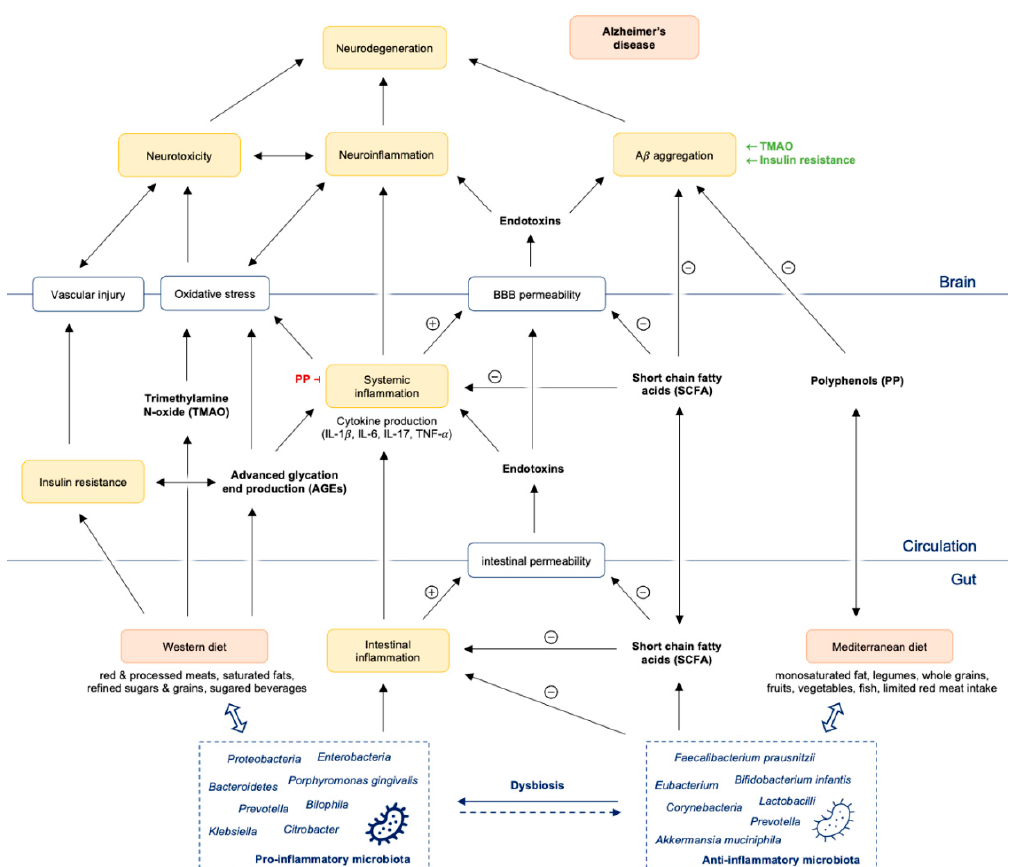
Figure 1. Gut dysbiosis promotes intestinal and systemic inflammation with consequently A β aggregation and neuroinflammation finally leading to neurodegeneration and Alzheimer’s disease. Abbreviations: A β = amyloid beta; PP = polyphenols; SCFA = short chain fatty acids; TMAO = trimethylamine N ‐ oxide; IL = interleukin; TNF = tumor necrosis factor; BBB = blood brain barrier.